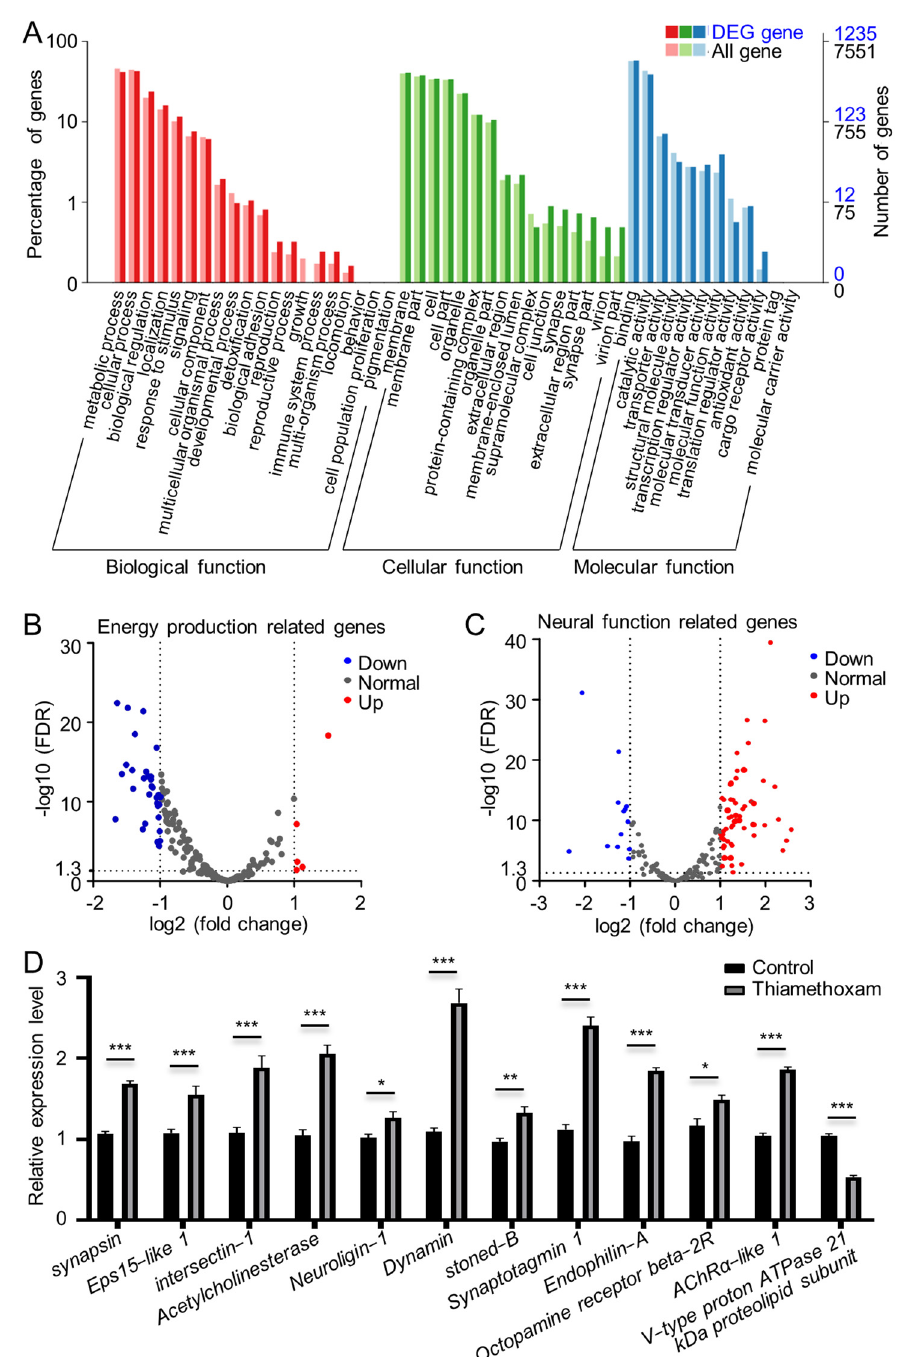
Figure 1. Genes were differentially expressed by exposure to TMX. ( A ) Analysis of DEGs with GO annotation. ( B ) Volcano plots of genes in energy production. ( C ) Volcano plots of genes in neural function. ( D ) qPCR confirmed the changes of the neurofunctional genes. * indicates significance with pairwise comparison of gene expression in the control and TMX treated aphids (Student’s t -test, *** p < 0.001, ** p < 0.01, and * p < 0.05).